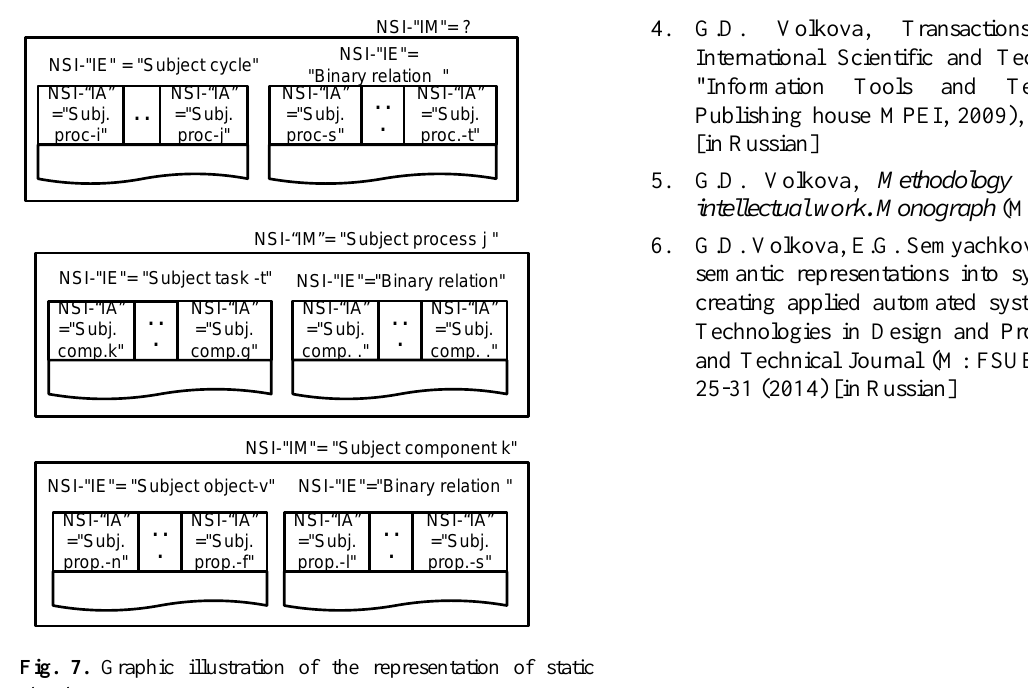
Fig. 7. Graphic illustration of the representation of static